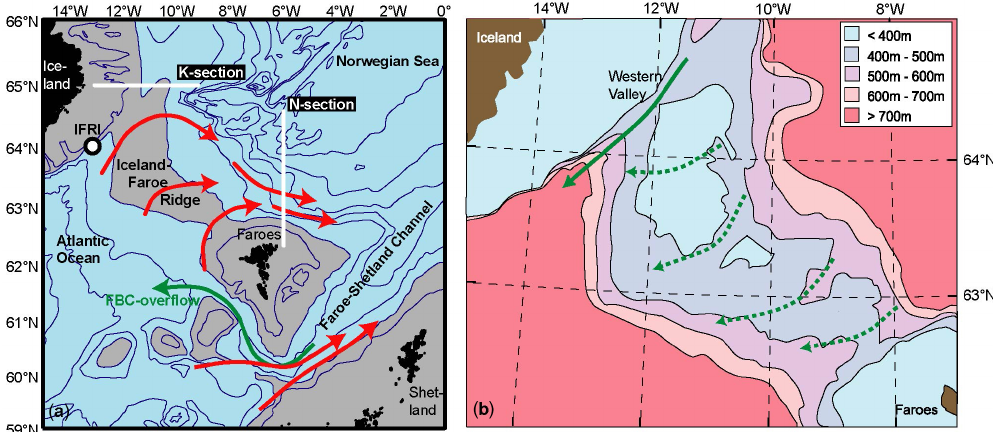
Figure 1. Map of the region (grey areas shallower than 500m) with red arrows schematically showing the flow of Atlantic water in the two main inflow branches and the green arrow the overflow through the Faroe Bank Channel (FBC). White lines indicate two standard sections. The circle indicates the location of ADCP mooring IFRI (a) . Detailed topography of the IFR with green arrows indicating persistent (continuous) and intermittent (dashed) overflow according to Hansen and Østerhus (2000) (b) .